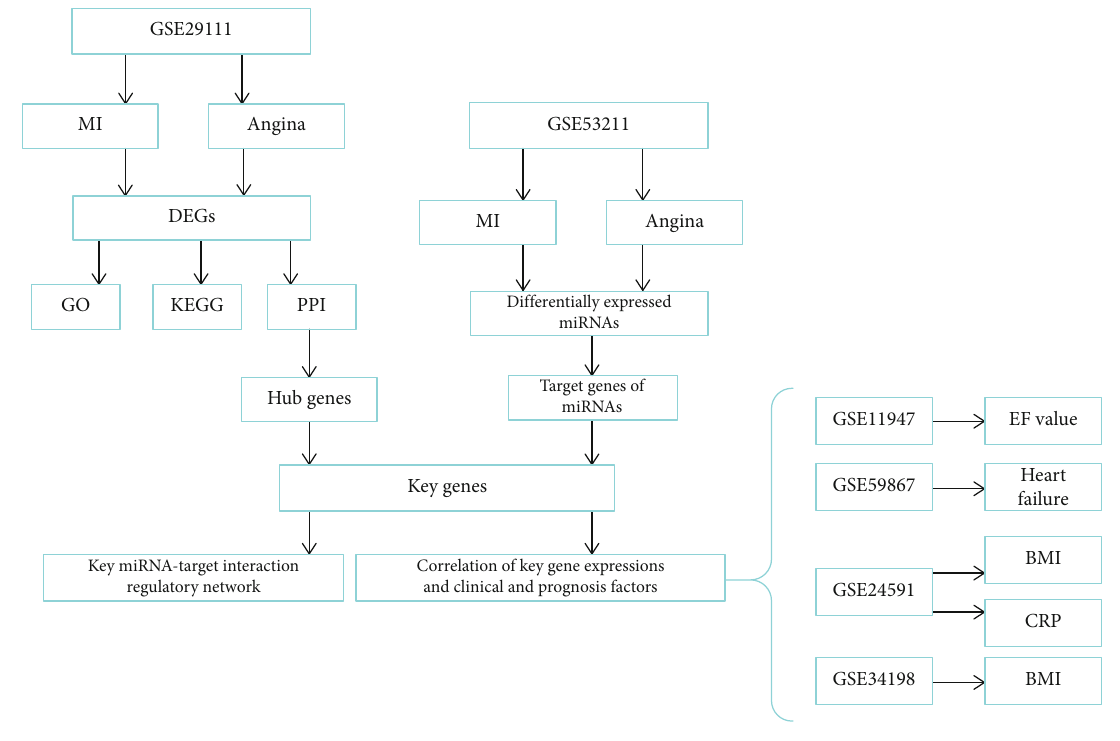
Figure 1: The bioinformatics analysis fl owchart. Table 1: Top 10 up- and downregulated DEGs in